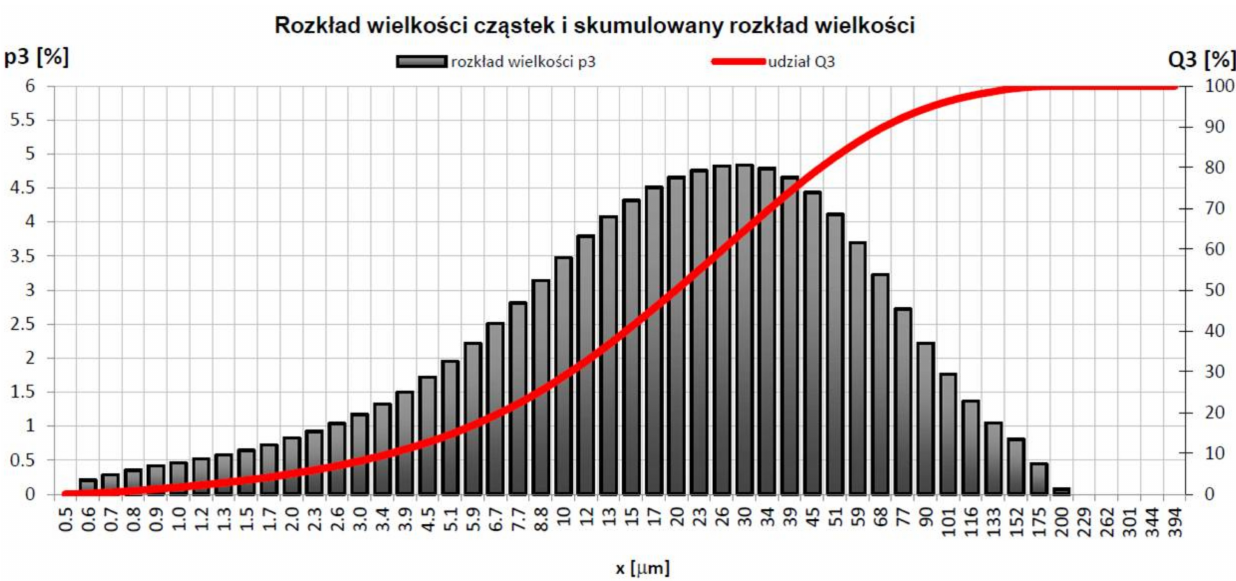
Figure 9. Particle size distribution and cumulative size distribution of FAB—fly ash from biomass